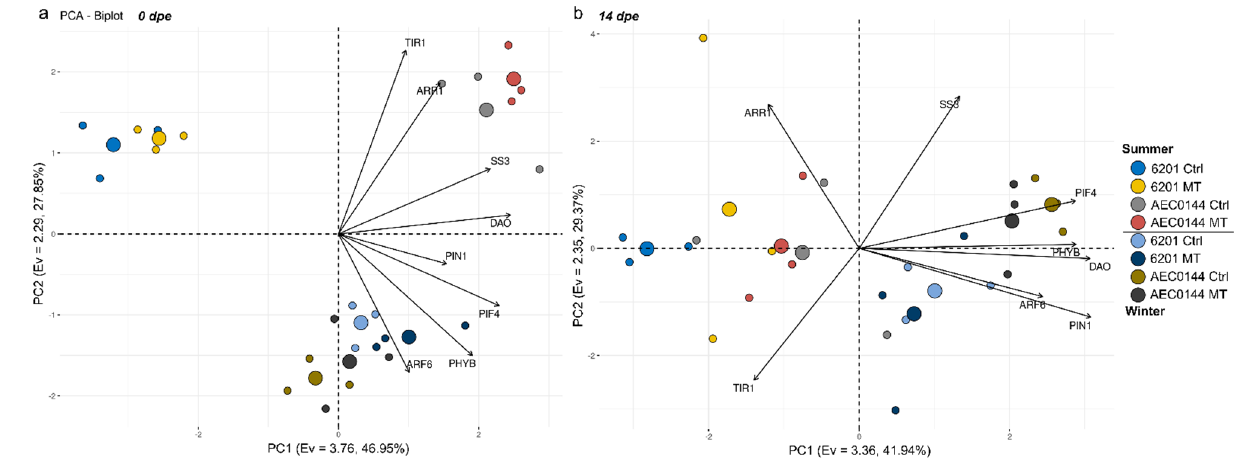
Figure 6. Principal component analysis of the relative gene expression levels at 0 dpe ( a ) and 14 dpe ( b ) in E. dunnii 6201 (hardR) and E. × urograndis AEC0144 (easyR) cuttings. Axes represent principal components (PC) with the corresponding eigenvalues (Ev) and percentage of variance explained. Regular circles represent biological replicates ( n = 3), while larger ones are the centroids for each group indicated in the legend.